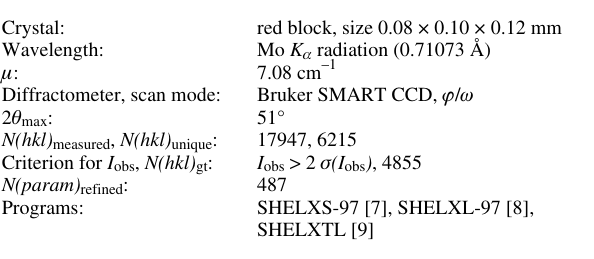
Table 1. Data collection and handling.